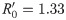
Surveillance data of the compartments for the endemic equilibrium.The reproduction number of the original strain is R0 = 3.33, while the reproduction number of the emergent strain is R0′=1.33. The vaccination rate used is 0.5.